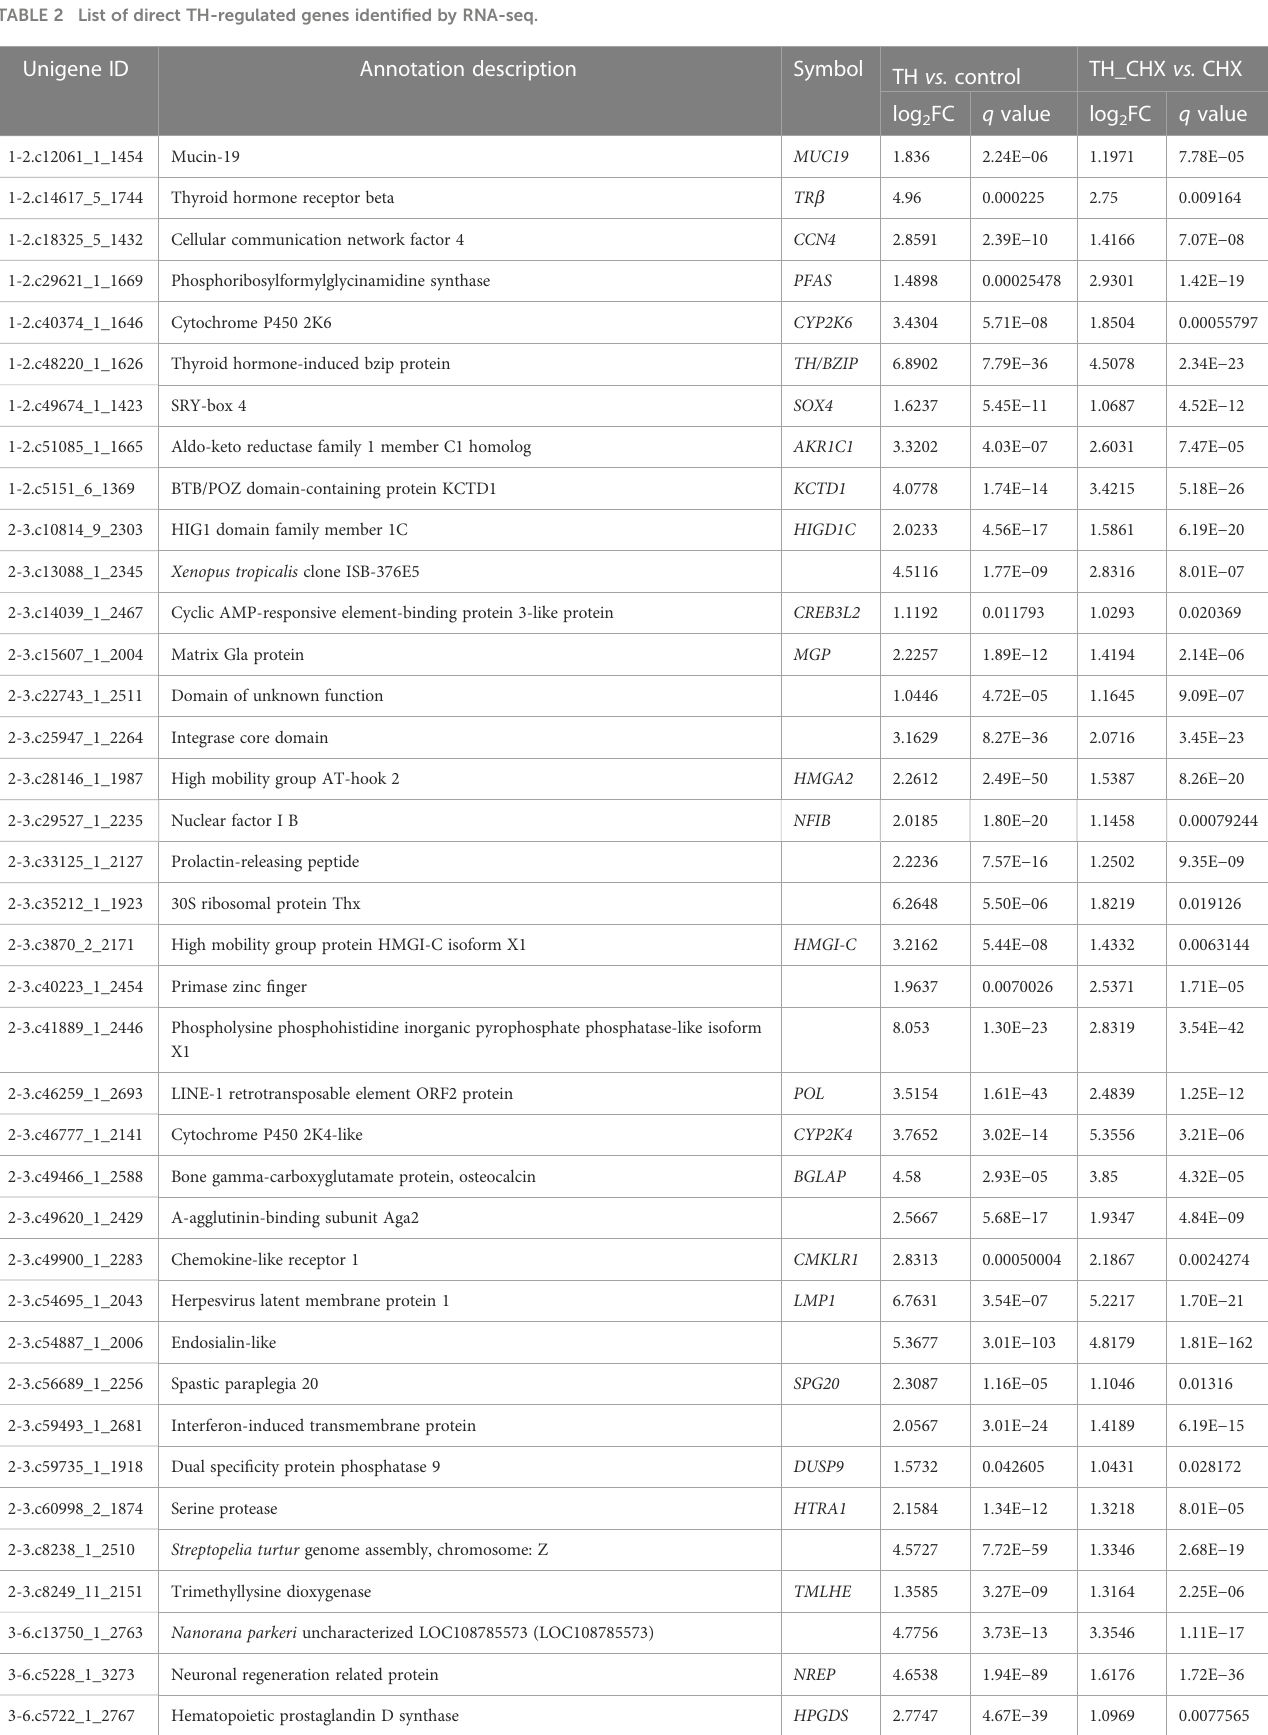
TABLE 2 List of direct TH-regulated genes identi fi ed by RNA-seq. Unigene